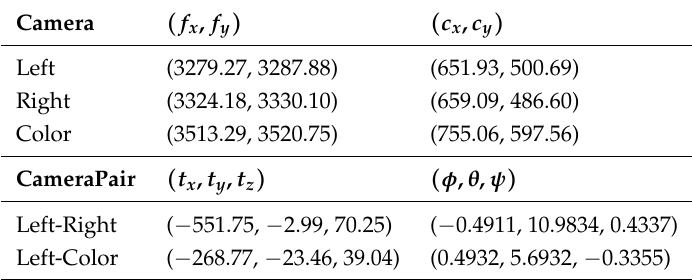
Table 1. Intrinsic and extrinsic parameters of triple cameras. The translation vector is given in millimeters (mm) and the rotation matrix presented in Euler angles (degrees) defined with the XYZ convention. Since the depth (disparity) map is computed in the rectified coordinate of left camera, the relative transform between left and color cameras is required to assign stereo depths to pixels in color images, thus creating pixel-wise aligned RGB-D pairs used by subsequent